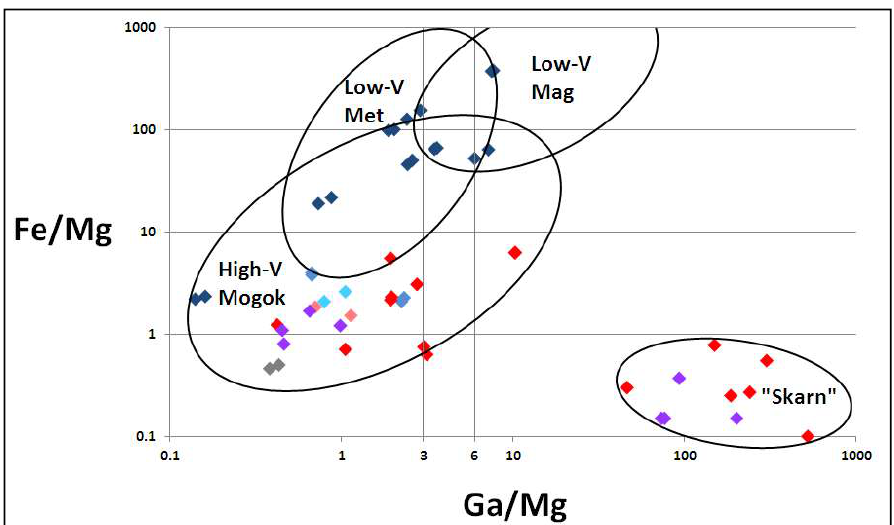
Figure 20. Fe/Mg vs. Ga/Mg plots Mogok corundum, as color coded plots within outlined fields for Mogok data [11,13]. Note extreme Ga/Mg ratios in a proposed “skarn” field for Le-U ruby (red diamonds) and Ohn-bin-ywe-htwet sapphire (mauve diamonds) [13], compared with Ga/Mg ratios plotted for Thurein Taung and Mong Hsu, Myanmar, Barrington Tops, Macquarie River and New England, East Australian ruby suites (Figure 18).